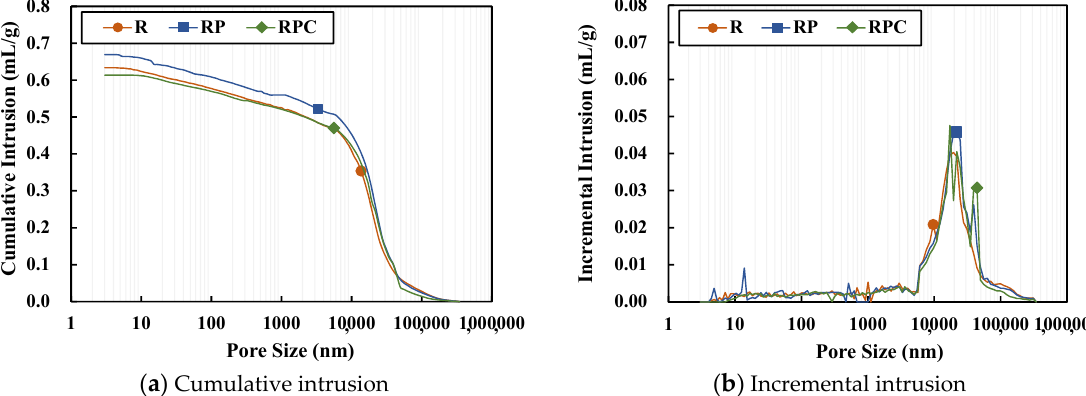
Figure 13. Mercury intrusion porosimetry outputs of the specimens of 28 days age.